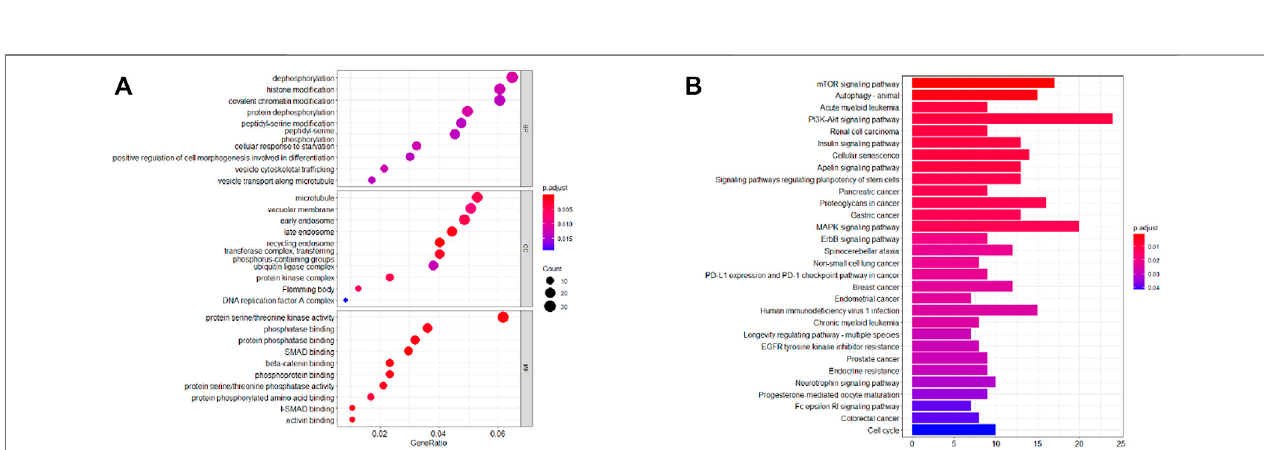
FIGURE8| FunctionalanalysisbasedontheMiRNAtargetgenesofthethreeDENSMs. (A) BubblegraphforGOenrichmentforDENSMstargetgenes(thebigger bubblemeansthemore genes enriched,and the increasing depthofred means thedifferencesweremore obvious; q-value: theadjusted p -value). (B) Barplotgraph for KEGG pathways for DENSMs target genes (the longer bar means the more genes enriched, and the increasing depth of red means the differences were more obvious).